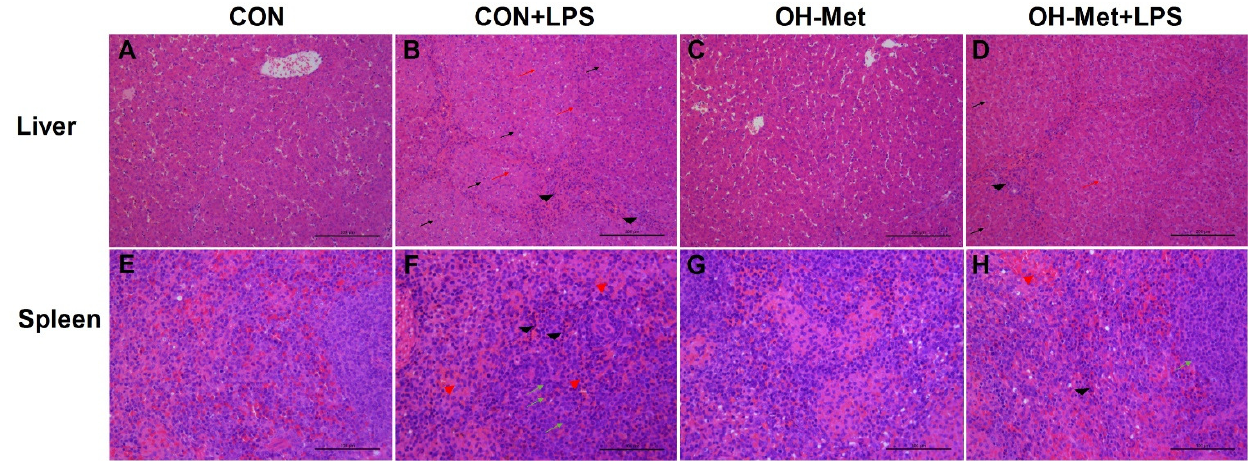
Figure 1. The effects of OH-Met supplementation on liver and spleen morphology after 24 h LPS- challenge in weaned piglets. The representative photomicrographs of liver and spleen sections that were stained with hematoxylin and eosin; photomicrographs are shown at 100× magnification (liver) and 200× magnification (spleen) magnification. Scale bars = 22.4 μm. The red arrow indicates narrowing of liver sinusoids; The black arrow indicates swelling; The black arrowhead indicates neutrophils infiltration; The red arrowhead indicates congestion; The green arrow indicates moder- ate lymphocytosis; CON, piglets receiving a control diet and injected with saline; CON+LPS, piglets receiving the control diet and challenged with LPS; OH-Met, piglets receiving a diet that was sup- plemented OH-Met at 25% above the total SAA present in the CON diet and injected with saline; OH-Met+LPS, piglets receiving a diet that was supplemented OH-Met at 25% above the total SAA present in the CON diet and challenged with LPS.